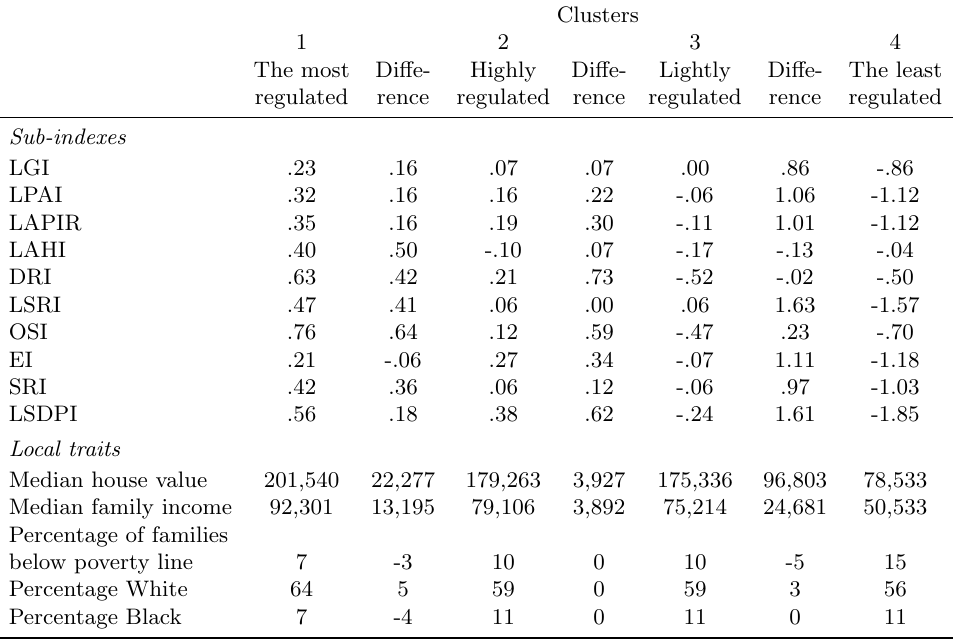
Table 4: Means of sub-indexes’ scores and local trait indicators by cluster Clusters 1 2 3 4 The most Diffe- Highly Diffe- Lightly Diffe- The least regulated rence regulated rence regulated rence regulated Sub-indexes LGI .23 .16 .07 .07 .00 .86 -.86 LPAI .32 .16 LAPIR .35 LAHI .40 DRI LSRI OSI EI .21 SRI LSDPI .56 Local traits Median house value 201,540 22,277 179,263 Median family income 92,301 13,195 79,106 3,892 75,214 24,681 50,533 Percentage of families below poverty line 7 -3 15 Percentage White 64 5 59 0 59 56 Percentage Black 7 -4